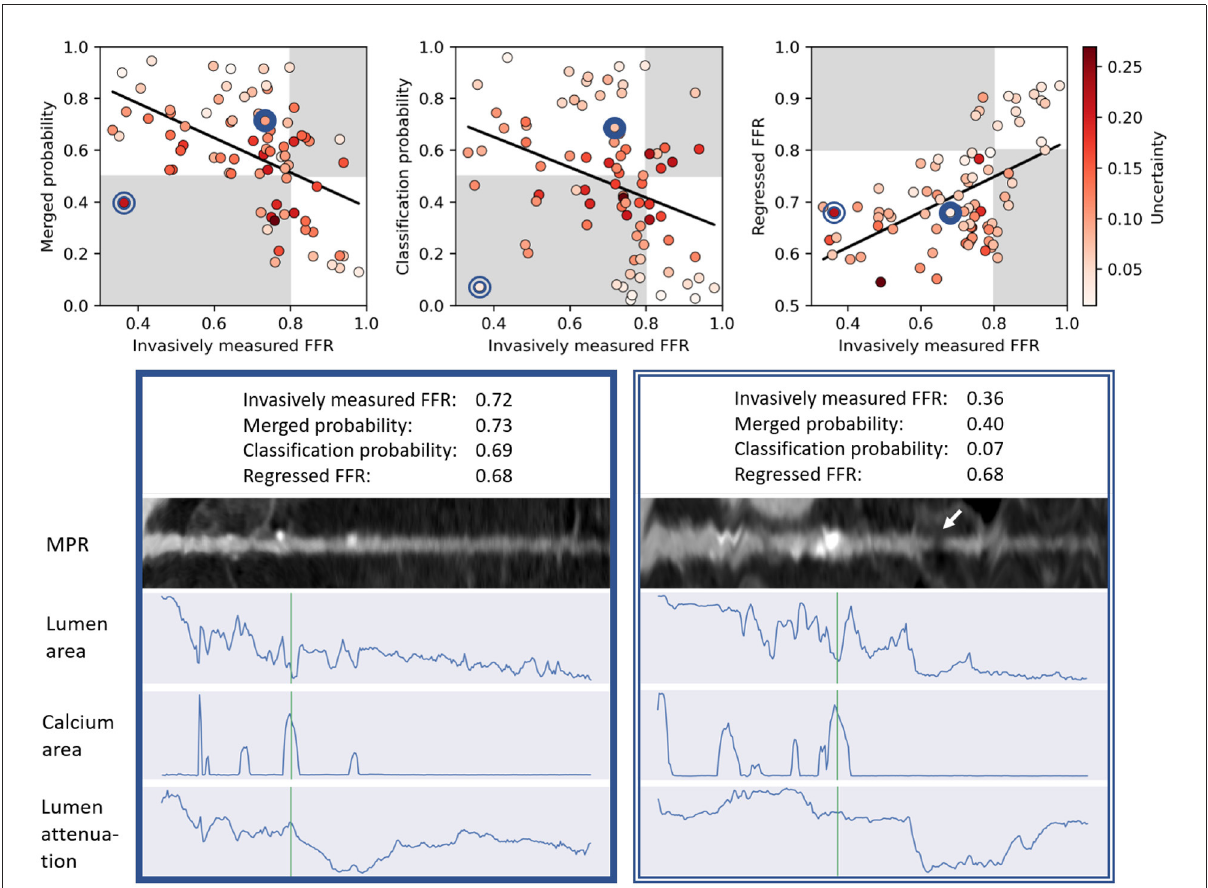
FIGURE7 Top: Scatter plots relating the invasively measured FFR with the predictions for each artery from the Test Cath data set. The graph on the left-hand side corresponds to the merged output probability, in the graph in the middle the output probability from the classification head is shown and in the graph on the right-hand side the regressed FFR value is depicted. Points are colored in red according to their prediction uncertainty. Background colors indicate in which arteries the functional significance was assessed correctly (white) or incorrectly (gray). Whereas, for probabilities (left and middle), high values correspond to the positive class, for regression (right), low output values correspond to the positive class. Black lines show the linear fit to the data. Bottom: MPRs and predicted characteristics for two arteries (positions in scatter plots indicated by blue circles). The location of the annotated lesion is plotted in green. Whereas the merged probability assigned to the artery on the left corresponds to the correct class, for the artery on the right, output of the classification head was strongly negative (low probability for functionally significant stenosis), which when combined with the regressed FFR caused the merged probability to yield the incorrect class. Incorrect output of the classification head may be related to a visually minor step-and-shot artifact causing a low intensity section in the MPR on the right (indicated by